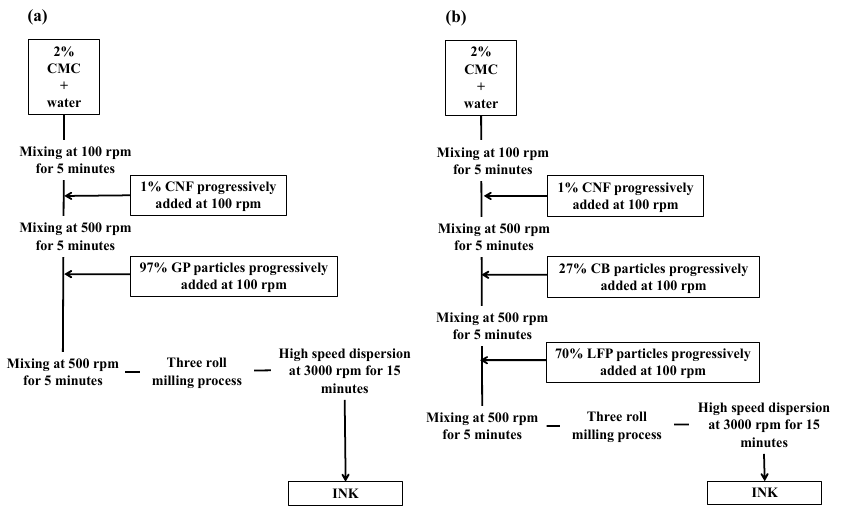
Figure 1. Flow chart of the formulation protocols used for the preparation of ( a ) negative and ( b ) positive electrodes.